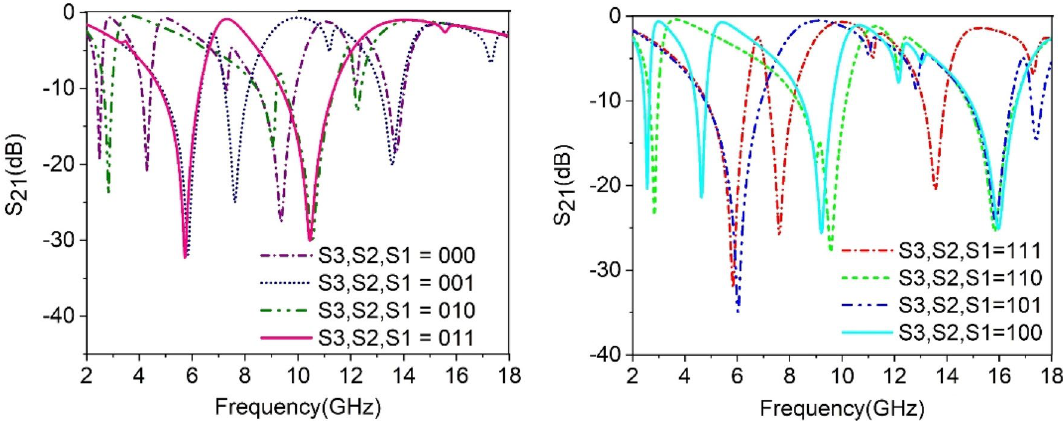
Figure 27. Frequency hopping by using switches at different split gaps of the resonators.